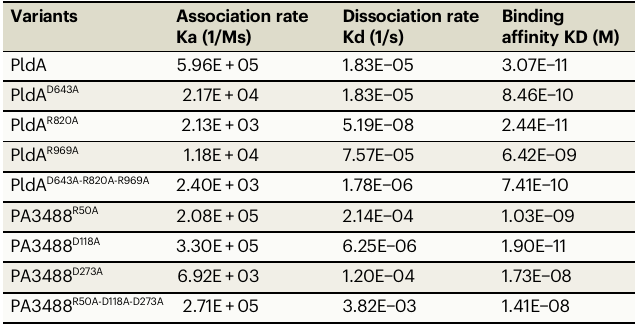
Table 1 | Kinetics and af fi nity constants for wild-type and mutant PldA – PA3488 complex